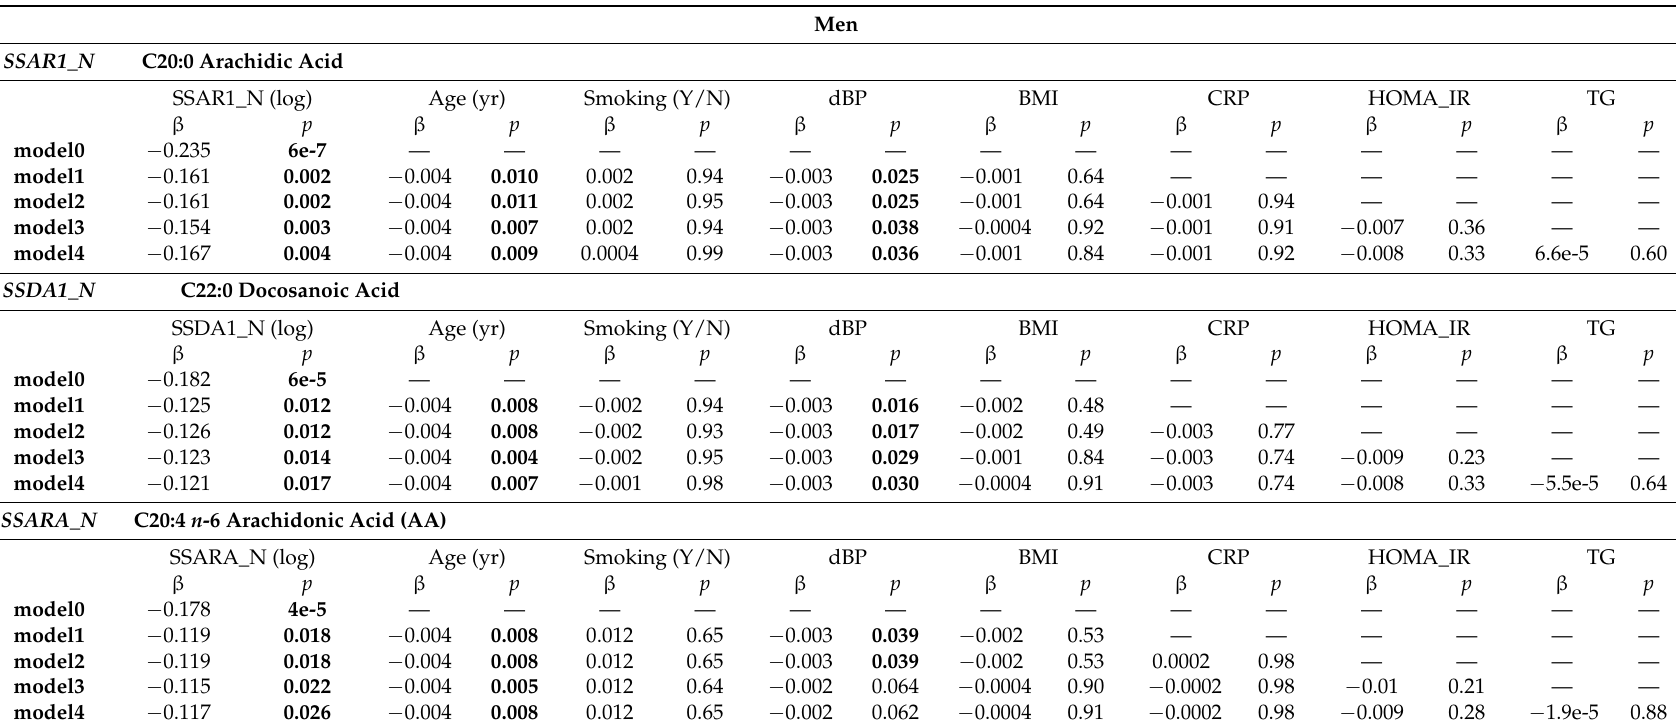
Table 5. Univariate and multivariate linear regression analysis in Men and Women